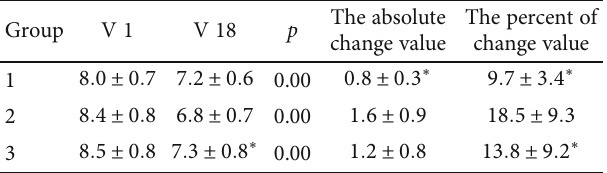
Table 4: The changes of HbA1c among the three groups.